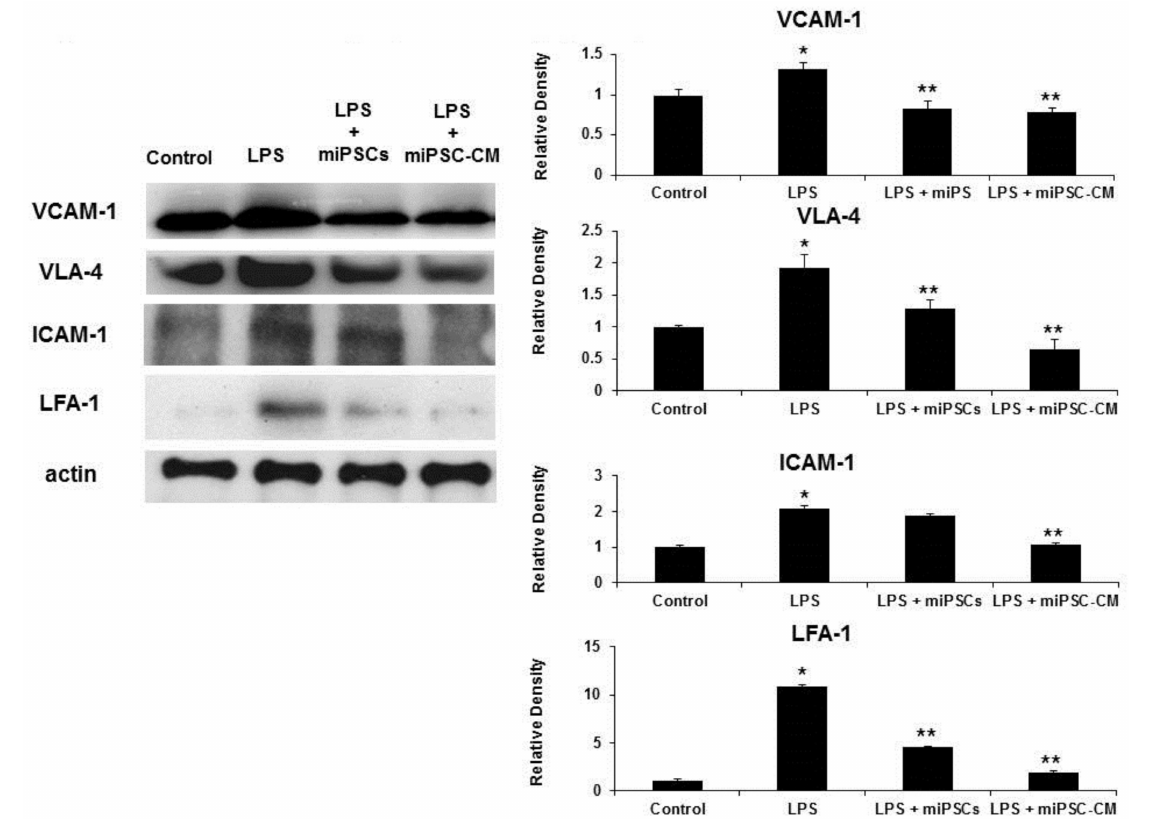
Figure 3. Western blot assays confirmed that LPS increased the expression of VCAM-1, VLA-4, ICAM-1, and LFA-1 in lung tissue. Administration of miPSCs or miPSC-CM reduced the expression of VCAM-1 and VLA-4 in LPS-induced ALI mice. However, the expression of ICAM-1 in LPS-induced ALI mice could not be reduced by miPSCs. Data are presented as the mean ± SD. * p < 0.05, compared to control mice; ** p < 0.05, compared to LPS-induced ALI mice; n = 6 per